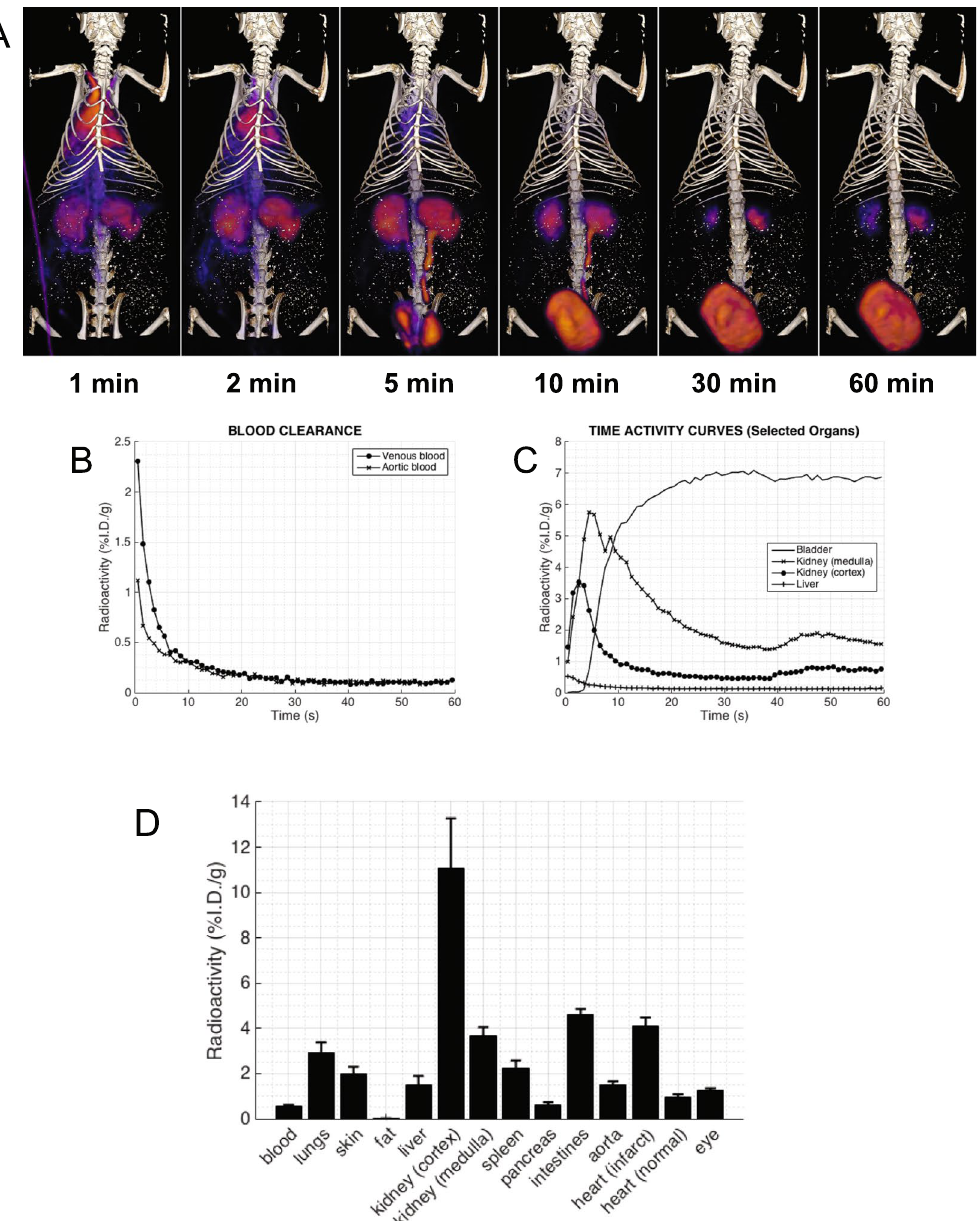
Figure 5. Dynamic PET-CT images ( A ) were used to plot the blood clearance ( B ) and time activity curves (TAC) of 64 Cu-NOTA-PEG 4 -cRGD 2 in selected organs ( C ). ( D ) Biodistribution of 64 Cu-NOTA-PEG 4 -cRGD 2 in selected organs at 90 min post-injection in Lewis rats subjected to myocardial infarction induced by surgical ligation of LAD. Results are expressed in percentage of injected dose per gram tissue (%I.D./g). These results suggest a rapid blood clearance through renal filtration and very low non-specific uptake in other critical